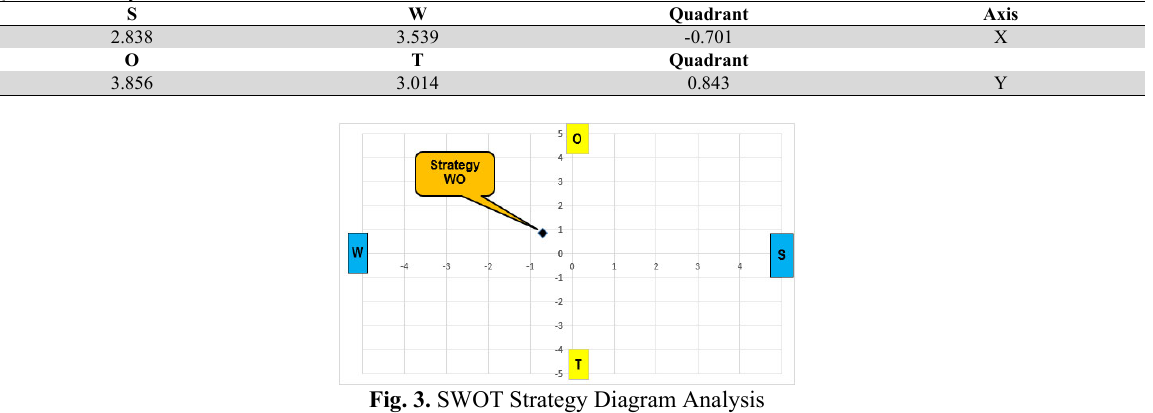
Quadrant Analysis on IFAS and EFAS